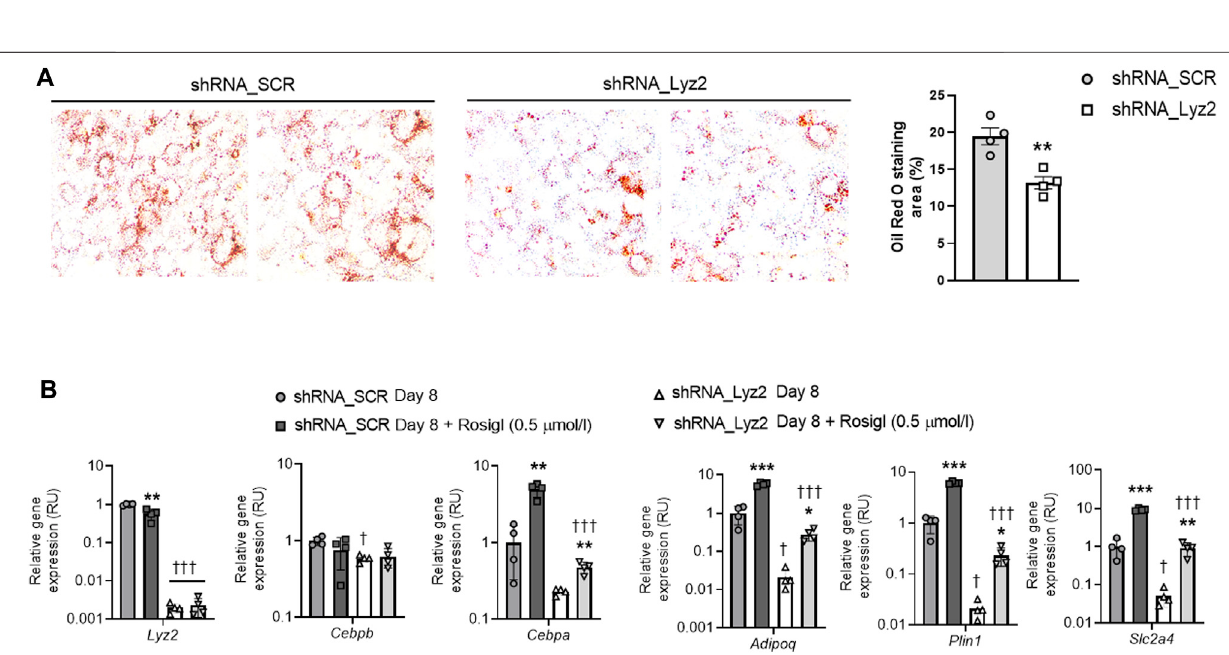
Frontiers in Cell and Developmental Biology |